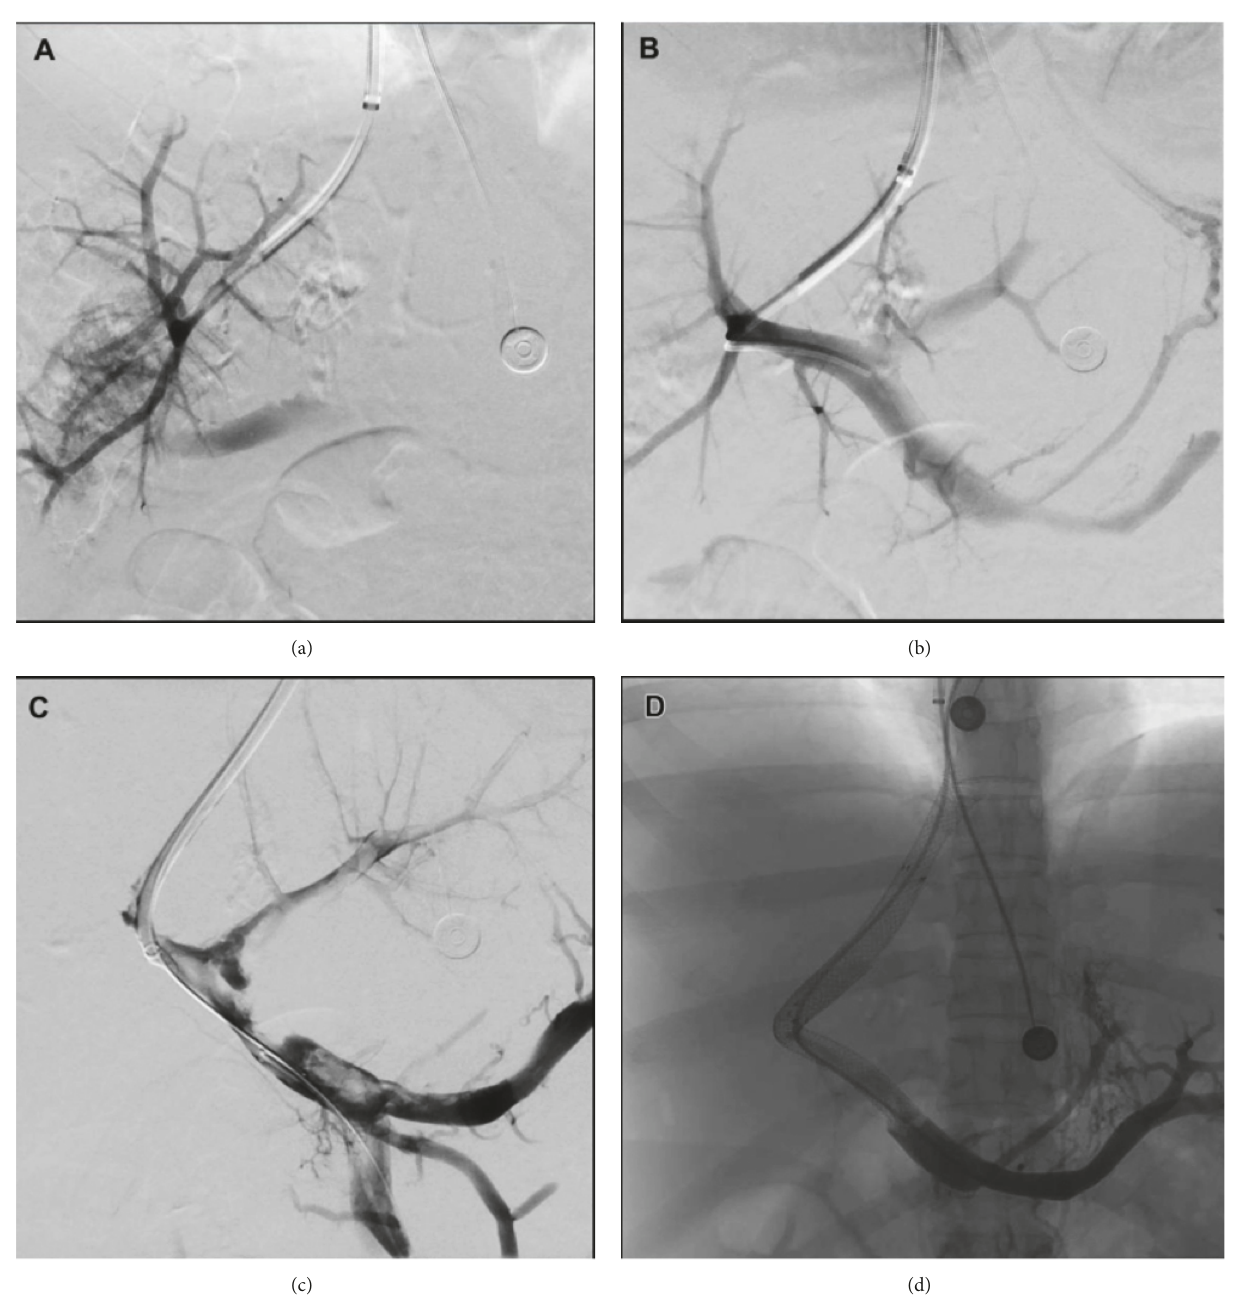
Figure 2: (a) Portal venography after initial needle access through DIPS. (b) Portal venography after introduction of sheath into the portal venous system. Note the presence of gastric varices. (c) Portal venography prior to creation and stenting of the DIPS. Note portal venous thrombosis disseminated throughout. (d) Unsubtracted post-DIPS and stenting portal venography. Note the absence of thrombosis and patency of the DIPS with brisk flow of